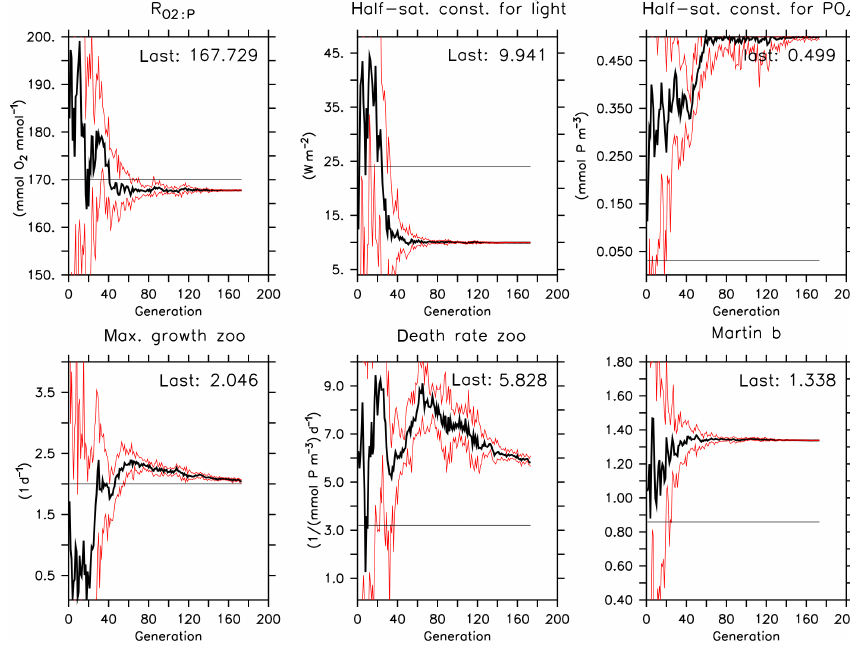
Figure 11. As Fig. 8, but for optimization OBS-WIDE-20. The optimization finished at generation 173.